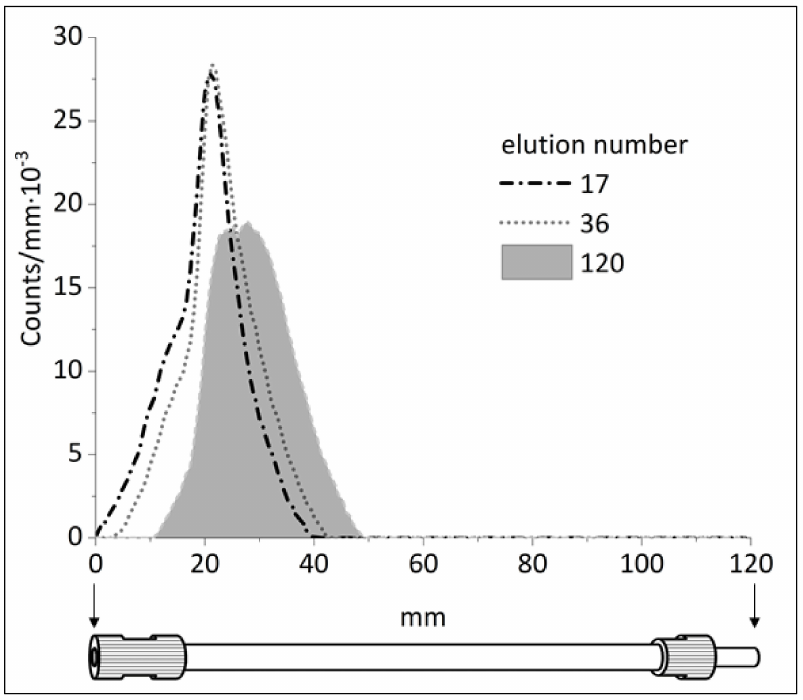
Figure 5. The activity distribution profiles of the generator column for increasing number of